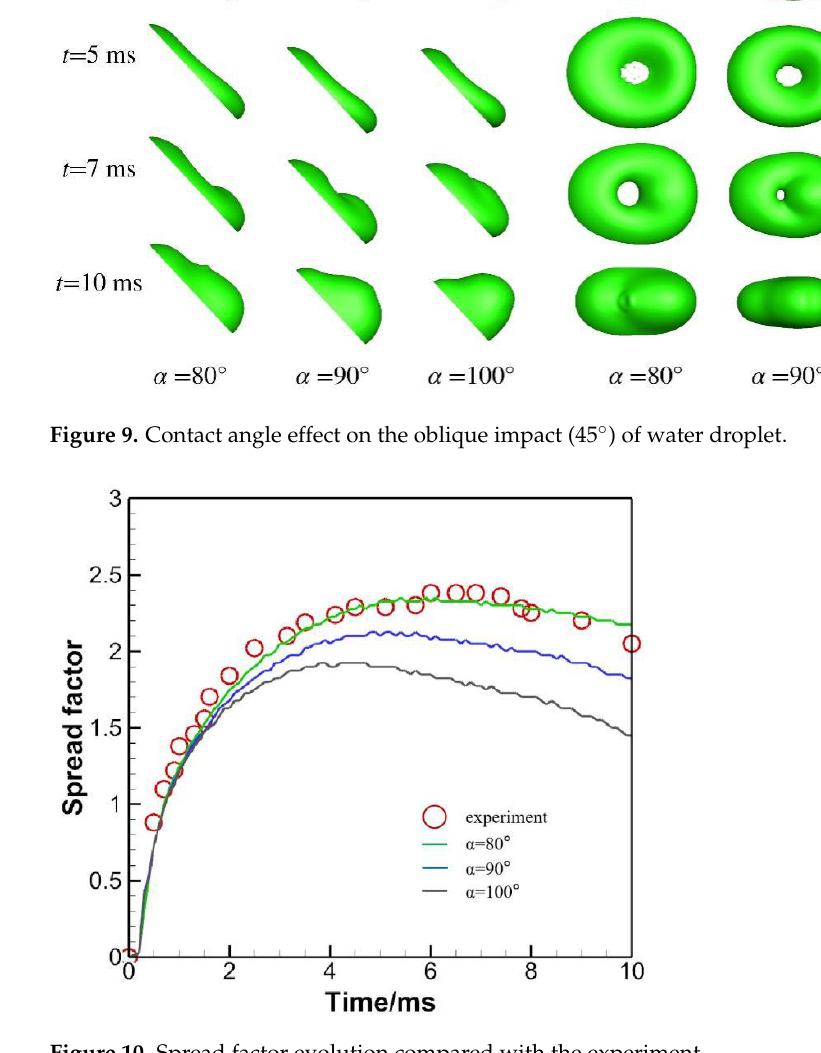
Figure 10. Spread factor evolution compared with the experiment.